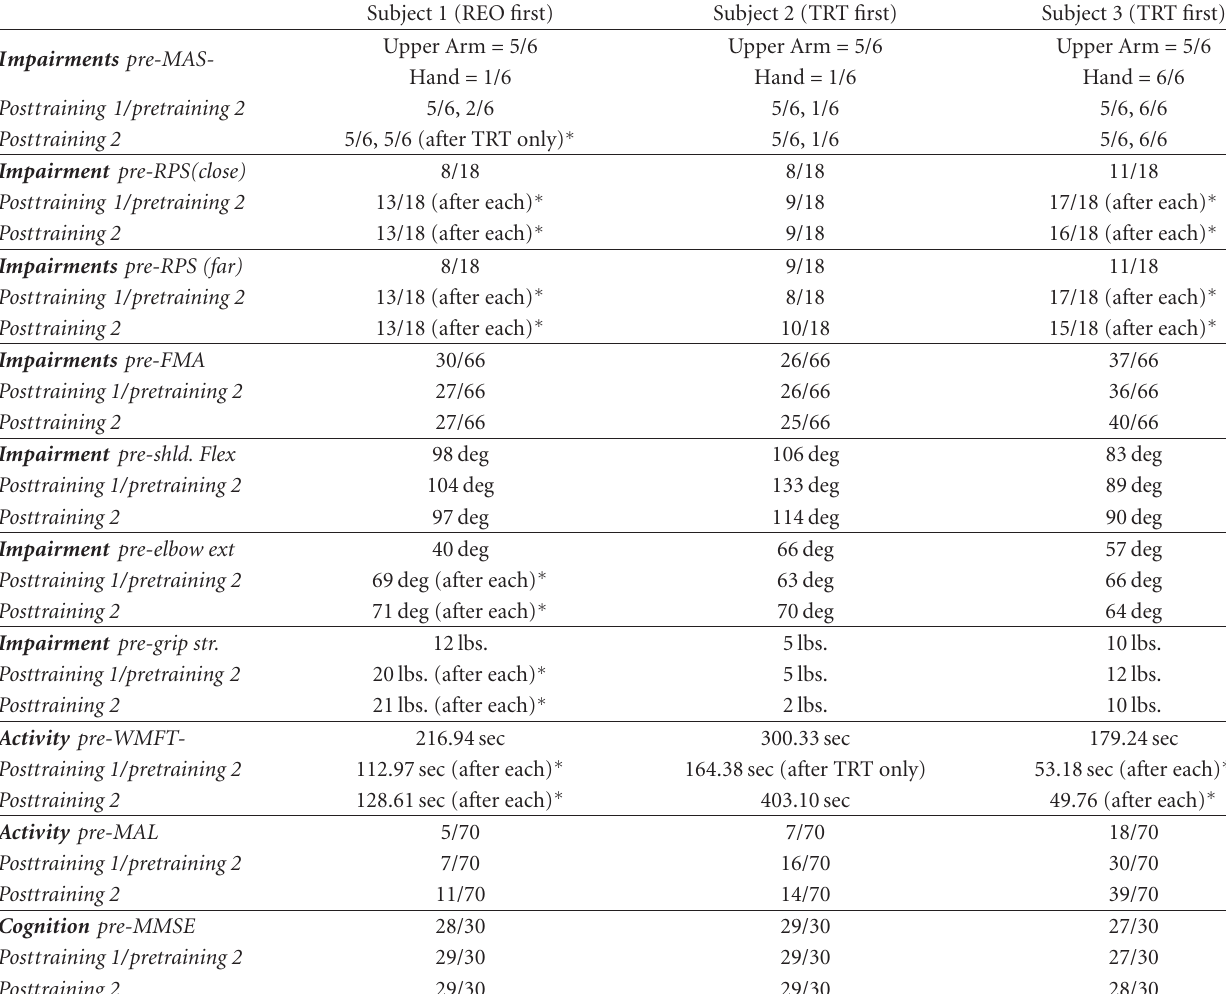
Table 1: Outcome